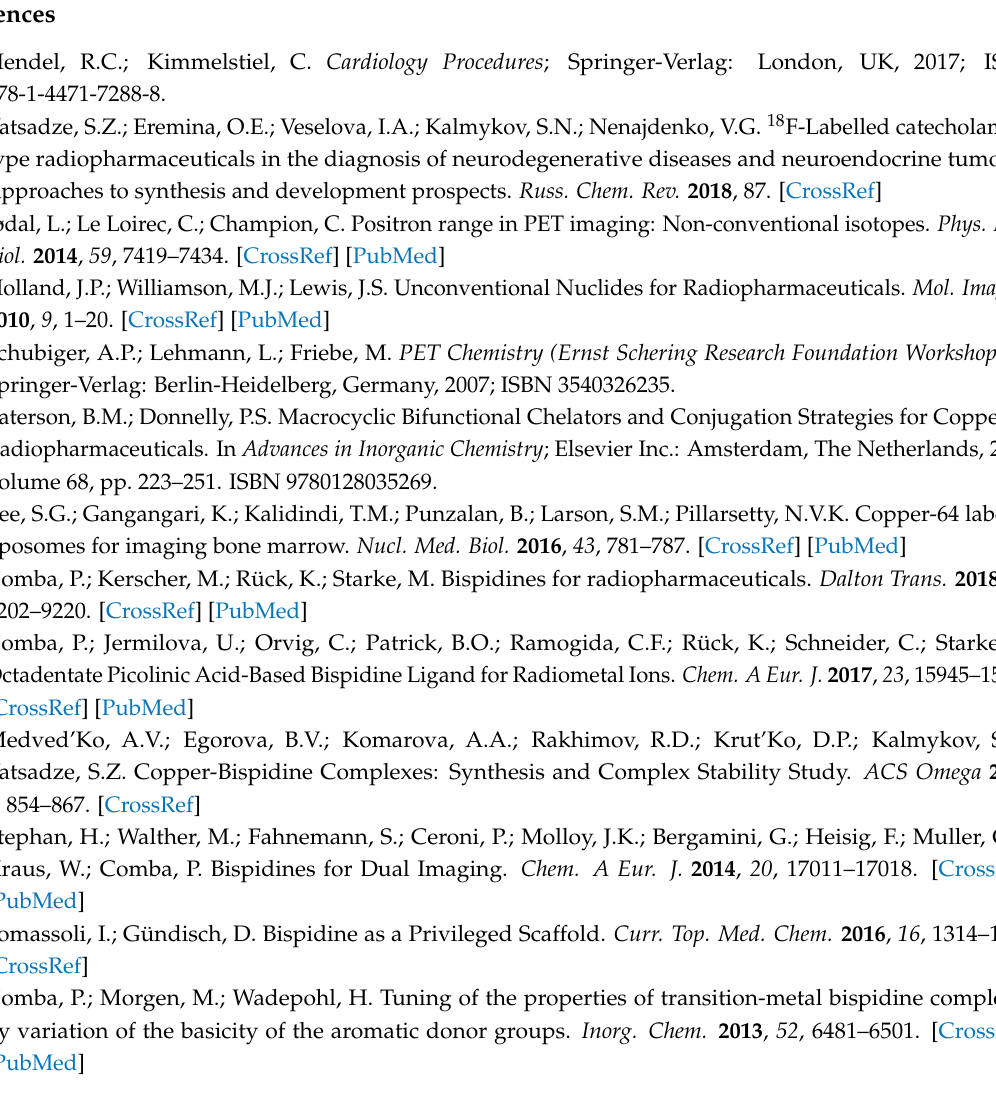
Table S2: Dependence of the loss and storage moduli on angular frequency, Table S3: Crystal data, data collection, structure solution, and refinement parameters for 4cb , 2c , 3a , 3c , 1b , 5,7-dimethyl-1,3-diazaadamantan-6-one , and 4da